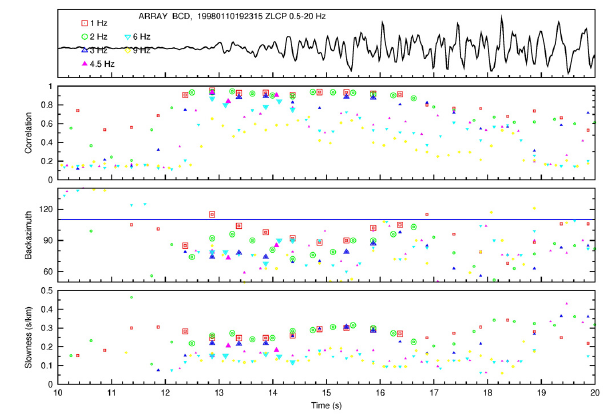
Figure 5. Results of ZLCC analysis (correlation, backazimuth and slowness) for the earthquake 19980110